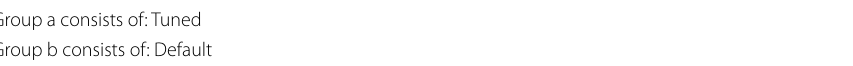
Table 26 HSD test groupings after ANOVA of AUC for the hyperparameters factor